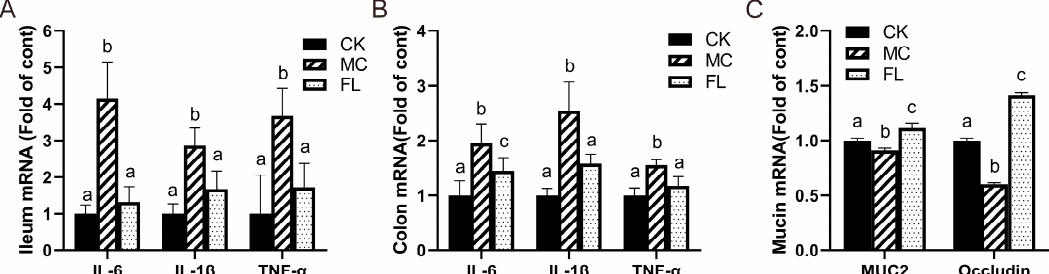
Figure 2. Relative mRNA levels of inflammatory cytokines and mucins, all normalized to β -actin mRNA expression. ( A ) Inflammatory cytokines in ileum; ( B ) inflammatory cytokines in colon; ( C ) expression of mucin in colon. Different letters (a–c) indicate significant differences of the same factor among groups ( p < 0.05).